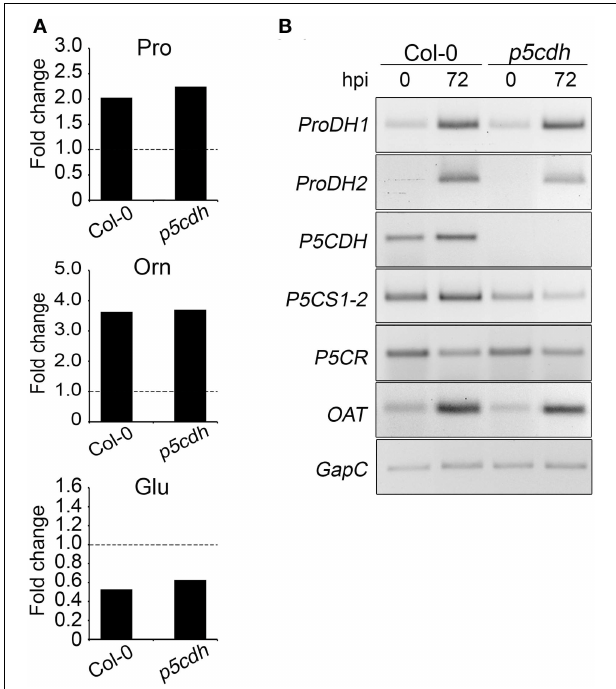
FIGURE 5 | Metabolic changes induced by Pst-AvrRpm1 infection in wild-type and p5cdh plants. (A) HPLC was used to determine the Pro, Glu, or Orn content in uninfected and infected tissues (72h post-infection, hpi) ( Supplementary Table 2 ). Fold changes of amino acid in infected and basal conditions are here informed. (B) Expression of genes of Pro metabolism evaluated at basal condition and 72 hpi as described in Figure 3B